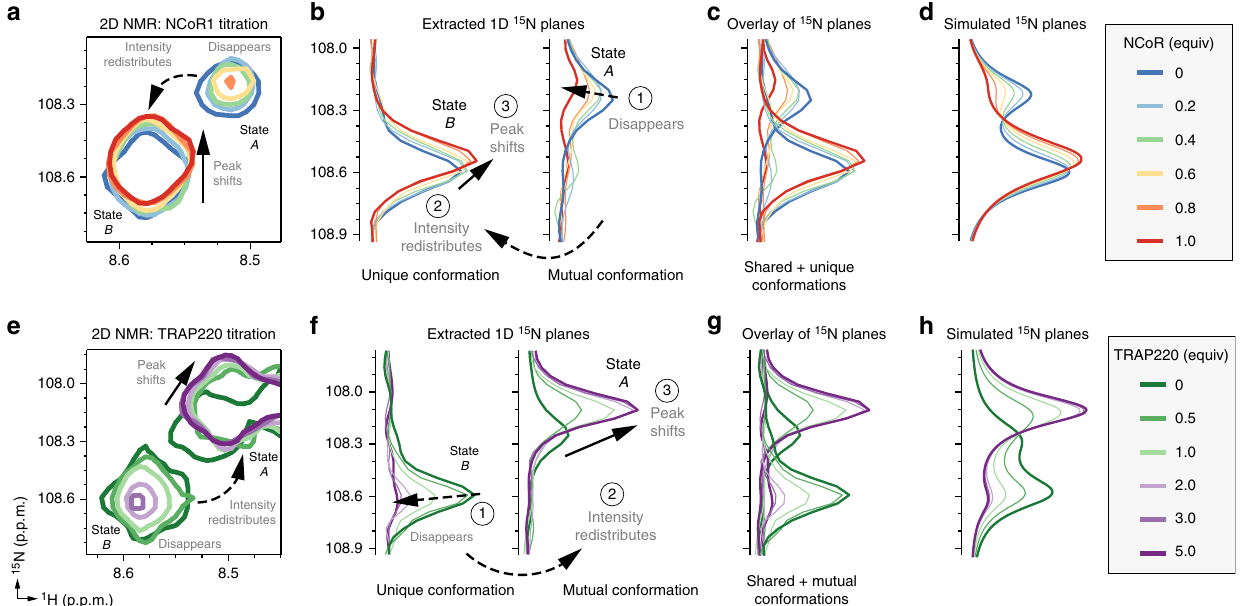
Fig. 7 Coregulator binding preferences of the unique and mutual T0070907-bound conformations. a Snapshot overlay of 2D [ 1 H, 15 N]-TROSY-HSQC spectra of T0070907-bound 15 N-labeled PPAR γ LBD titrated with NCoR1 peptide. b Extracted 1D planes of the NCoR1 spectra shown in a show the qualitative binding trends observed by NMR, whereas c an overlay of the extracted 1D planes is quantitatively described by d spectra using a 4-state model where the two slowly exchanging receptor populations (R and R*) are capable of binding to the peptide (RP and R*P), and receptor isomerizes in both the free and peptide-bound states (R ↔ R*, and RP ↔ R*P). ( e – h ) Analysis of performed for T0070907-bound 15 N-labeled PPAR γ LBD titrated with TRAP220 peptide performed similarly to the NCoR1 analysis described in a – d , which is also quantitatively described using the same 4-state the peak populations towards the unique state B (Supplementary bound PPAR γ LBD caused peak doubling of the GW9662-bound Figure 12D) and TRAP220 binding shifts the peak populations G399 NMR peak towards chemical shift values similar to the towards the mutual state A (Supplementary Figure 12E). NCoR1- and TRAP220-bound forms of T0070907-bound PPAR γ We also used NMR to examine the coregulator binding LBD (Fig. 8a). NMR line shape modeling revealed that the 2D properties of GW9662-bound 15 N-labeled PPAR γ LBD, which NMR pro fi le was best fi t (Fig. 8b) using a 3-state model only shows the mutual conformation. Interestingly, whereas (Supplementary Figure 13) where the receptor binds to the peptide (R + P ↔ RP), and the peptide-bound receptor slowly consolidated the unique and mutual conformations into one isomerizes between two states (RP ↔ R*P). In contrast, TRAP220 coregulator-bound conformation, NCoR1 binding to GW9662- binding only shifted the single GW9662-bound G399 peak